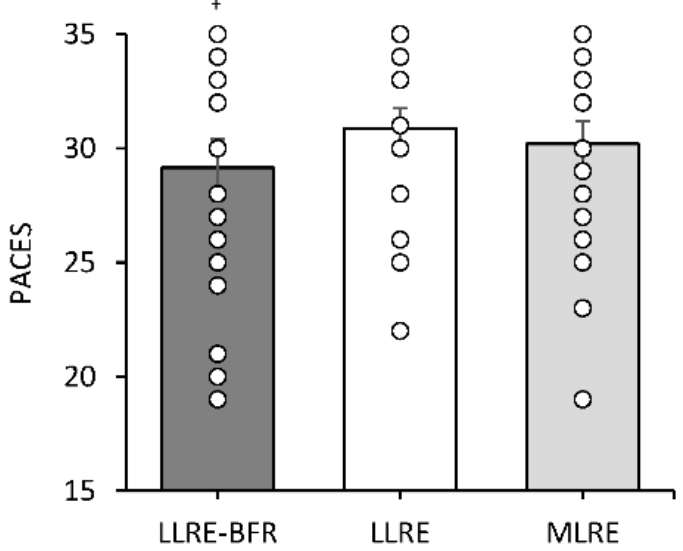
Figure 4. Sum of Physical Activity Enjoyment Scale measured 15 min post exercise session dis- playing individual data points to provide information regarding individual responses to